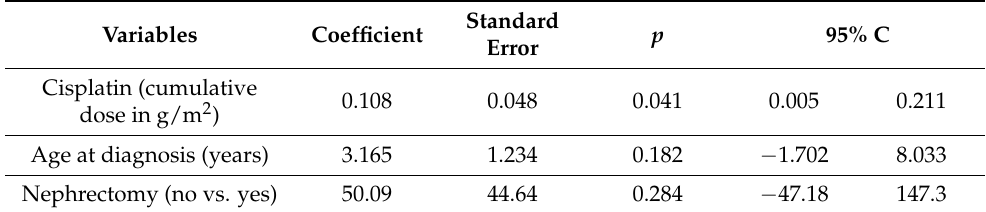
Table 6. Multiple linear regression analysis of the NGAL/creatinine ratio in childhood solid tu- mors survivors. Standard Variables Coefficient